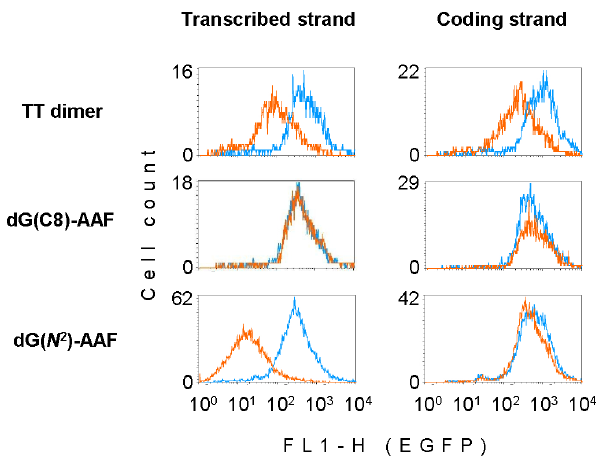
Figure S3 Stable knockdown of the endogenous CSB